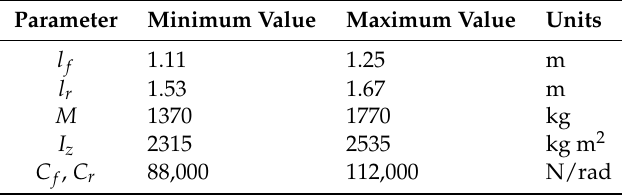
Table 2. Variation of the model